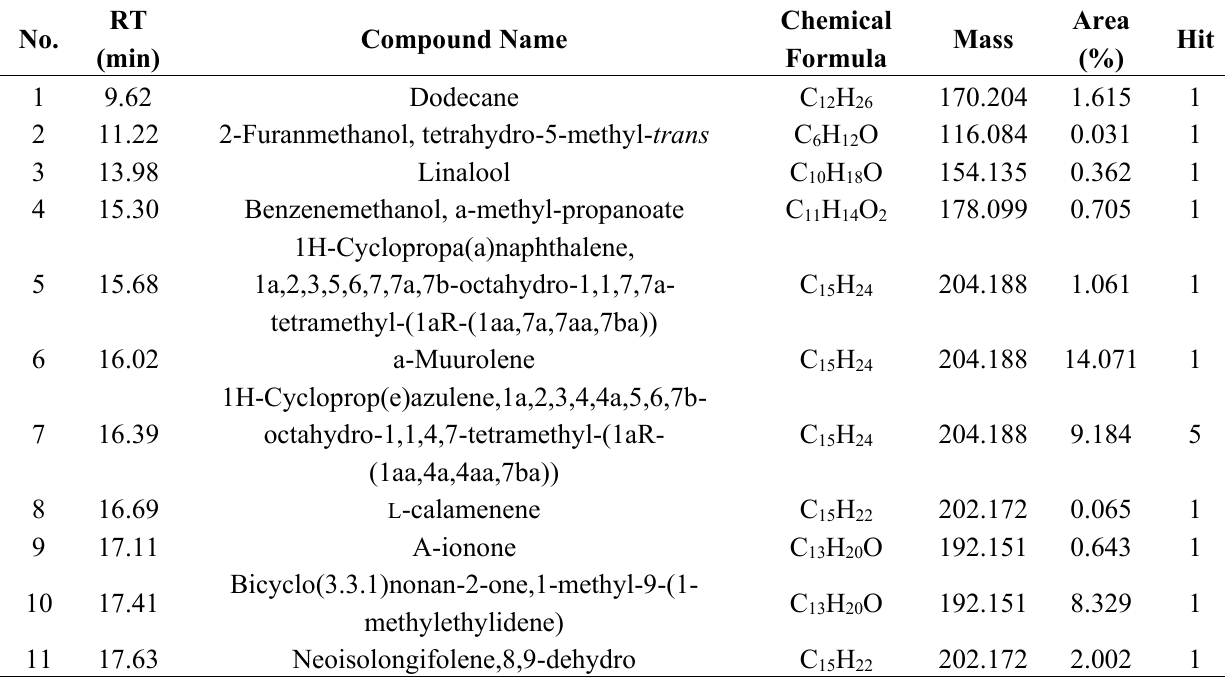
Figure 2. Total ion chromatogram of the hexane fraction of N. jatamansi . Table 2. Phytochemical analysis of the N. jatamansi hexane